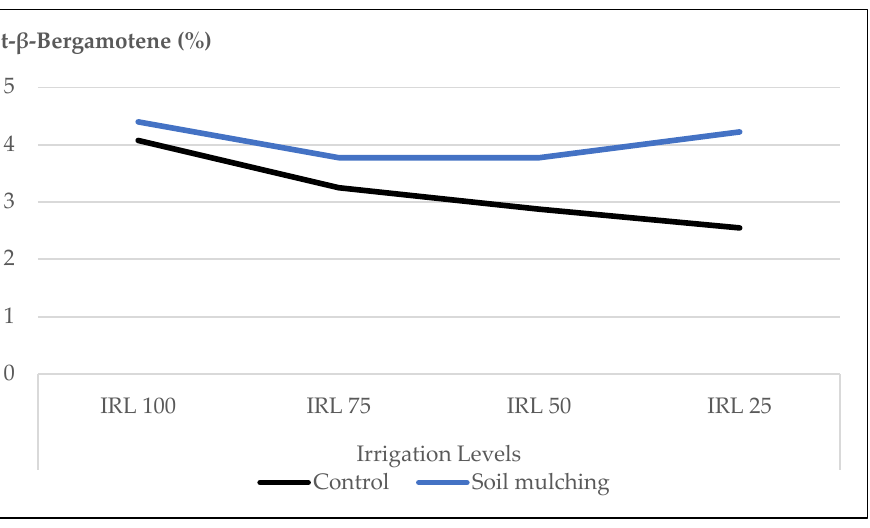
Figure 11. Mean values of (E)- β -bergamotene (%) at different IRLs of O. basilicum L. essential oil under soil mulching and control conditions; IRL 100 = 100% FC; IRL 75 = 75% FC; IRL 50 = 50% FC; IRL 25 = 25% FC.